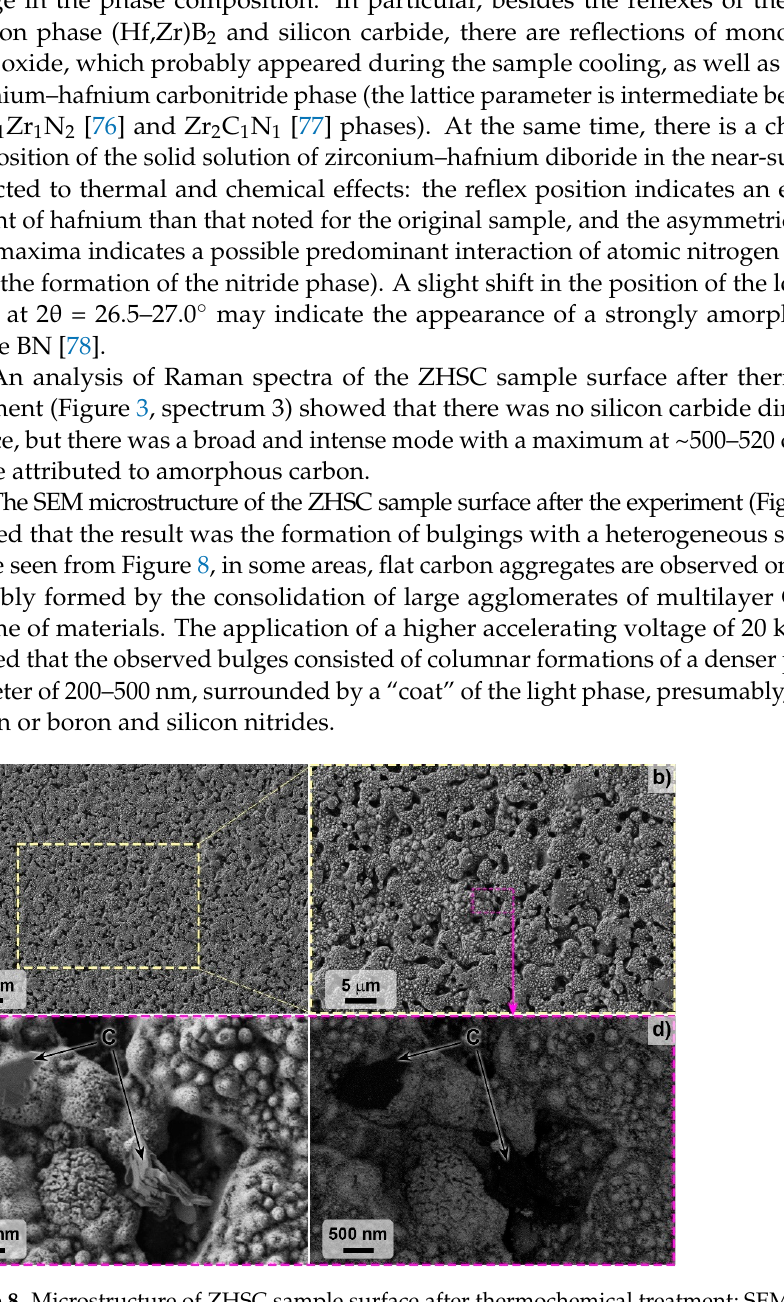
Figure 8. Microstructure of ZHSC sample surface after thermochemical treatment; SEM, accelerating voltage 1 kV: ( a – c )—according to secondary electron detector data, ( d )—in contrast mode by mean atomic number.